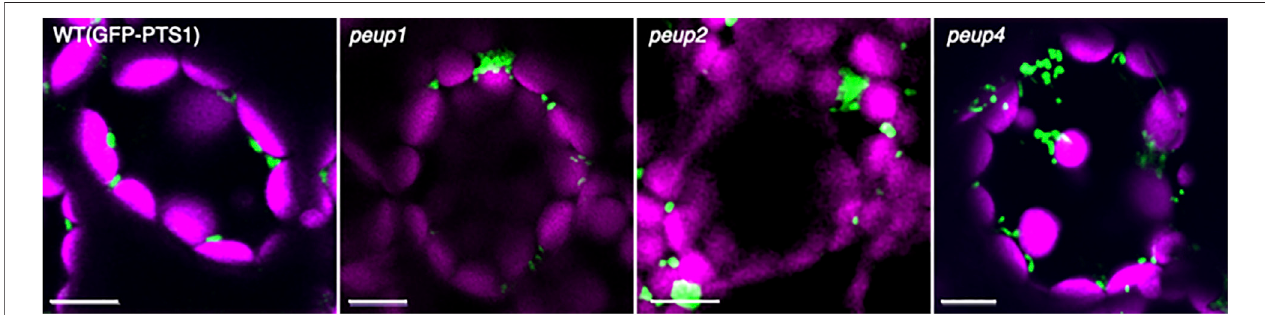
FIGURE 3 | Peroxisome aggregation in peup mutants. Representative images ofperoxisomes(green) and chloroplasts (magenta) in leaf mesophyll cells of the WT plant and peup mutants (Shibata et al., 2013; Goto-Yamada et al., 2019). Peroxisomes associate with chloroplasts in the WT plant, whereas peroxisomes partially form aggregates in peup mutants. Bars, 10 µm.